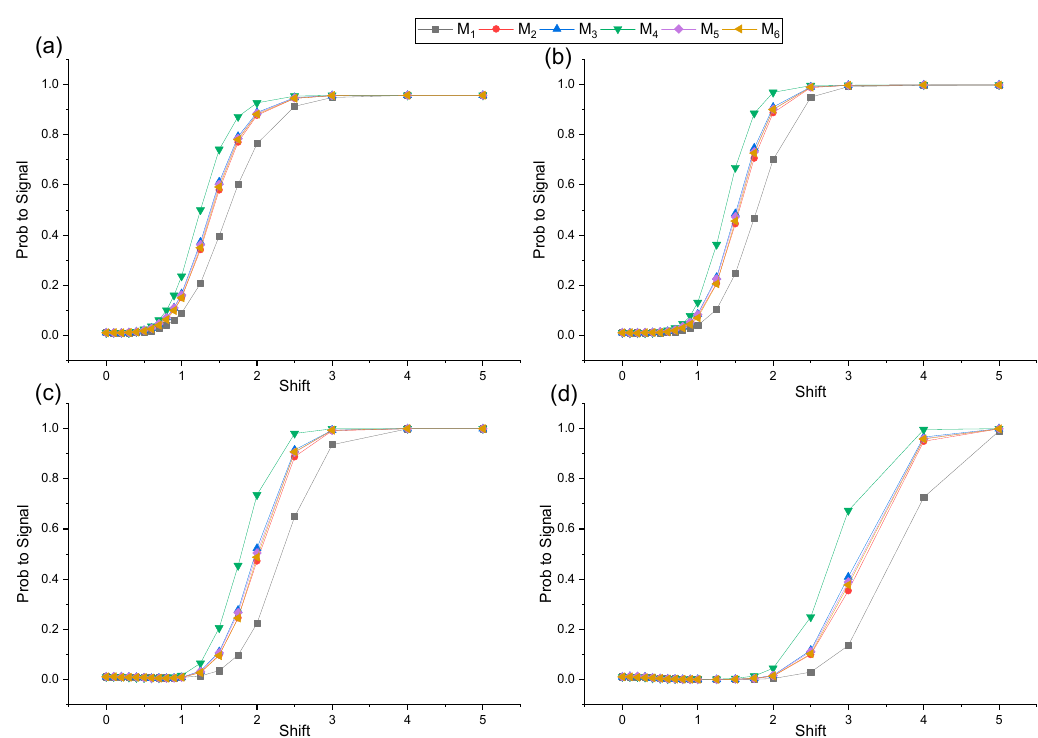
Figure 4. Probability to signal plot for di ff erent auxiliary information based median charts using n = 10, m = 30, ρ = 0.80 and α = 0.01 at ( a ) m 1 = 3, ( b ) m 1 = 6, ( c ) m 1 = 9, ( d ) m 1 = 12.